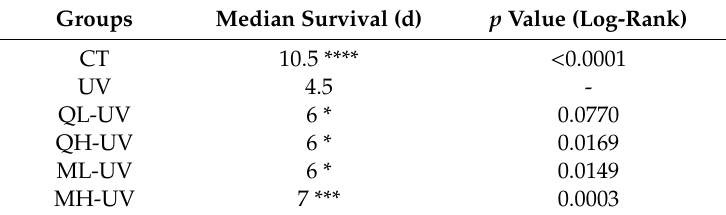
Figure 3. Lifespan test results of C. elegans . ( a ) The survival curves of the drugs + UV (100 J / M 2 ) treatment groups. ( b ) The survival curves of the drug treatment groups without UV irradiation ( n = 50). Table 2. Analysis of survival curves for each UVB-treated